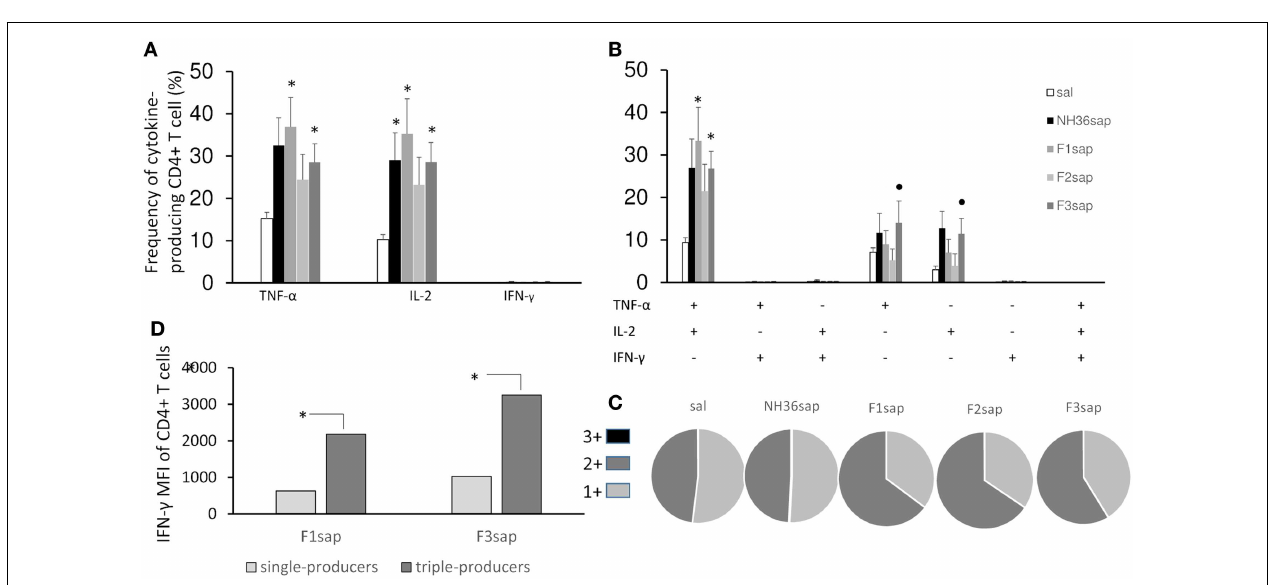
secretion expressed by its median intensity fluorescence (MFI) in single- and triple-cytokine CD4 + T cell producers and (D) the fraction of the total response comprising cells expressing all three cytokines (3 + ), any two cytokines (2 + ), or any one cytokine (1 + ). Results shown as the mean ± SE of two independent experiments with n = 6–7 in each experiment. *Significant differences from saline treated controls, • significant differences from the F2sap